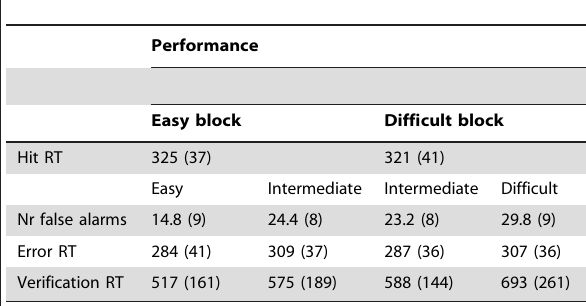
Table 1. Performance data EEG